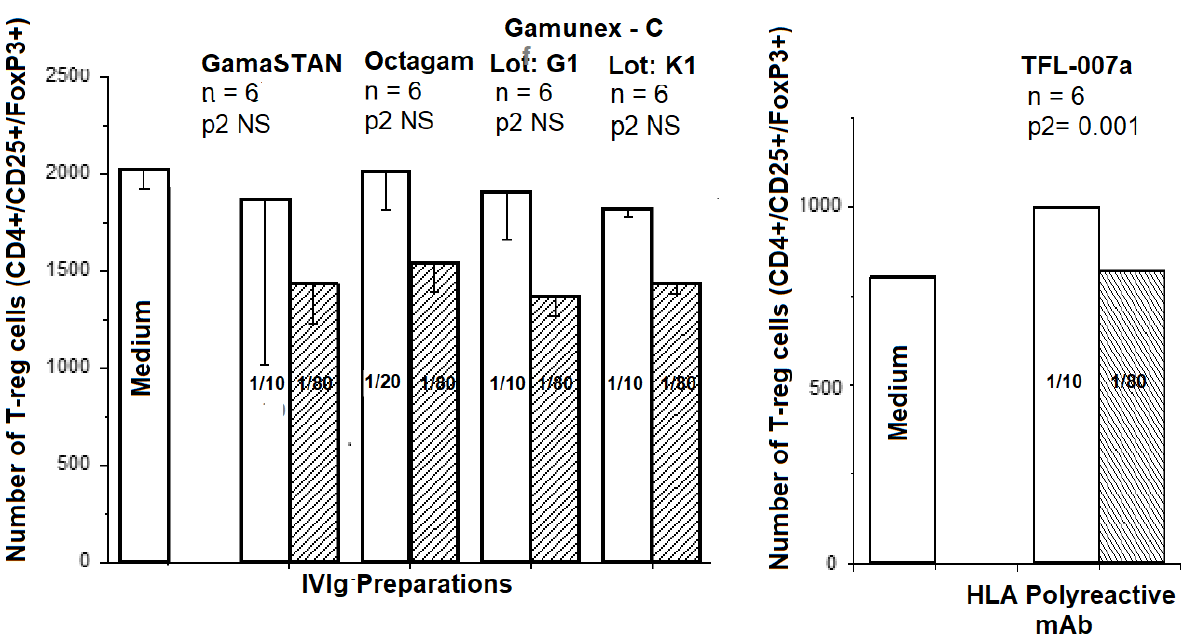
Figure 11. Effects of different commercial preparations of IVIg, which included GamaSTAN™ S/D (15–18 gm%, Lot 26NHCVI; (Talecris Biotherapeutics, Inc., Research Triangle Park, NC, USA) at dilutions 1/10 (concentration 15 mg/mL) and 1/80 (concentration 1.2 mg/mL), octagam ® (6 gm%, Lot A913A8431; Octapharma Pharmazeutika) at dilutions 1/20 (concentration 3 mg/mL) and 1/80 (concentration 0.75 mg/mL), Gamunex ® -C (10 gm%, Lots 26NKLG1 and 26NKLK1; Telacris) at dilutions 1/10 (concentration 10 mg/mL) and 1/80 (concentration 8 mg/mL), and mAb TFL-007a (at dilution 1/10, concentration 62.7 µ g/mL; 1/80, concentration 7.84 µ g/mL) on PHA-untreated cells were compared with the effect of medium alone on the proliferation of Treg cells, defined as CD4+/CD25+/Foxp 3 +. Note that IVIg preparations used in this study failed to upregulate Tregs, in contrast to TFL-007a, which significantly upregulated Treg cells at dilution 1/10. This figure is original but derived and modified from a previous report